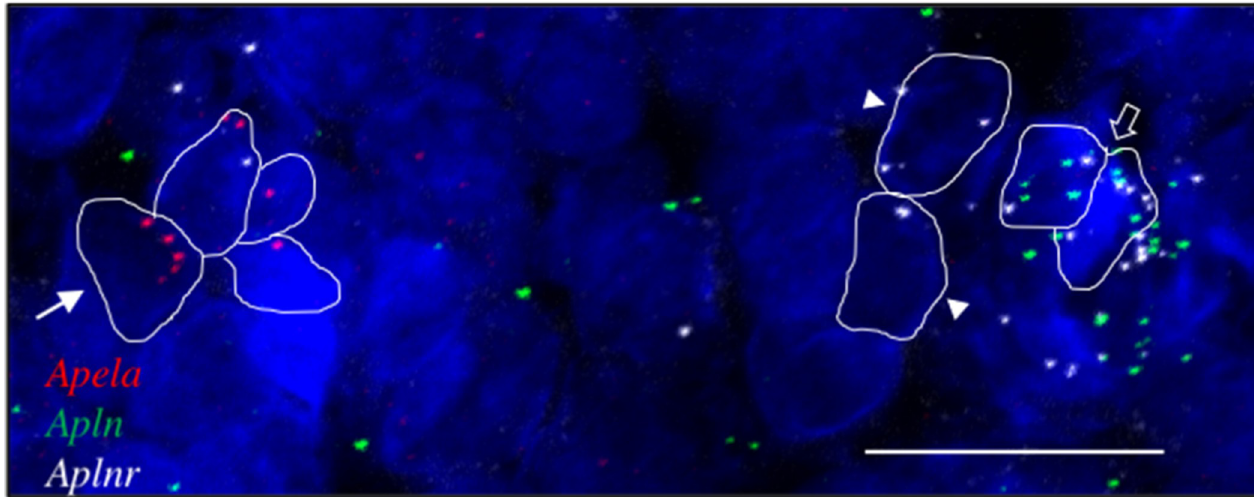
Fig 4. Aplnr , apln and apela transcripts in the SHR AP. Representative fluorescent images showing cells expressing apela (red dots; arrowed), aplnr (white dots, arrowheads) and apln (green dots). Cells co-expressing aplnr and apln are indicated (open arrow). Scale bar = 50 μ m. n = 4.